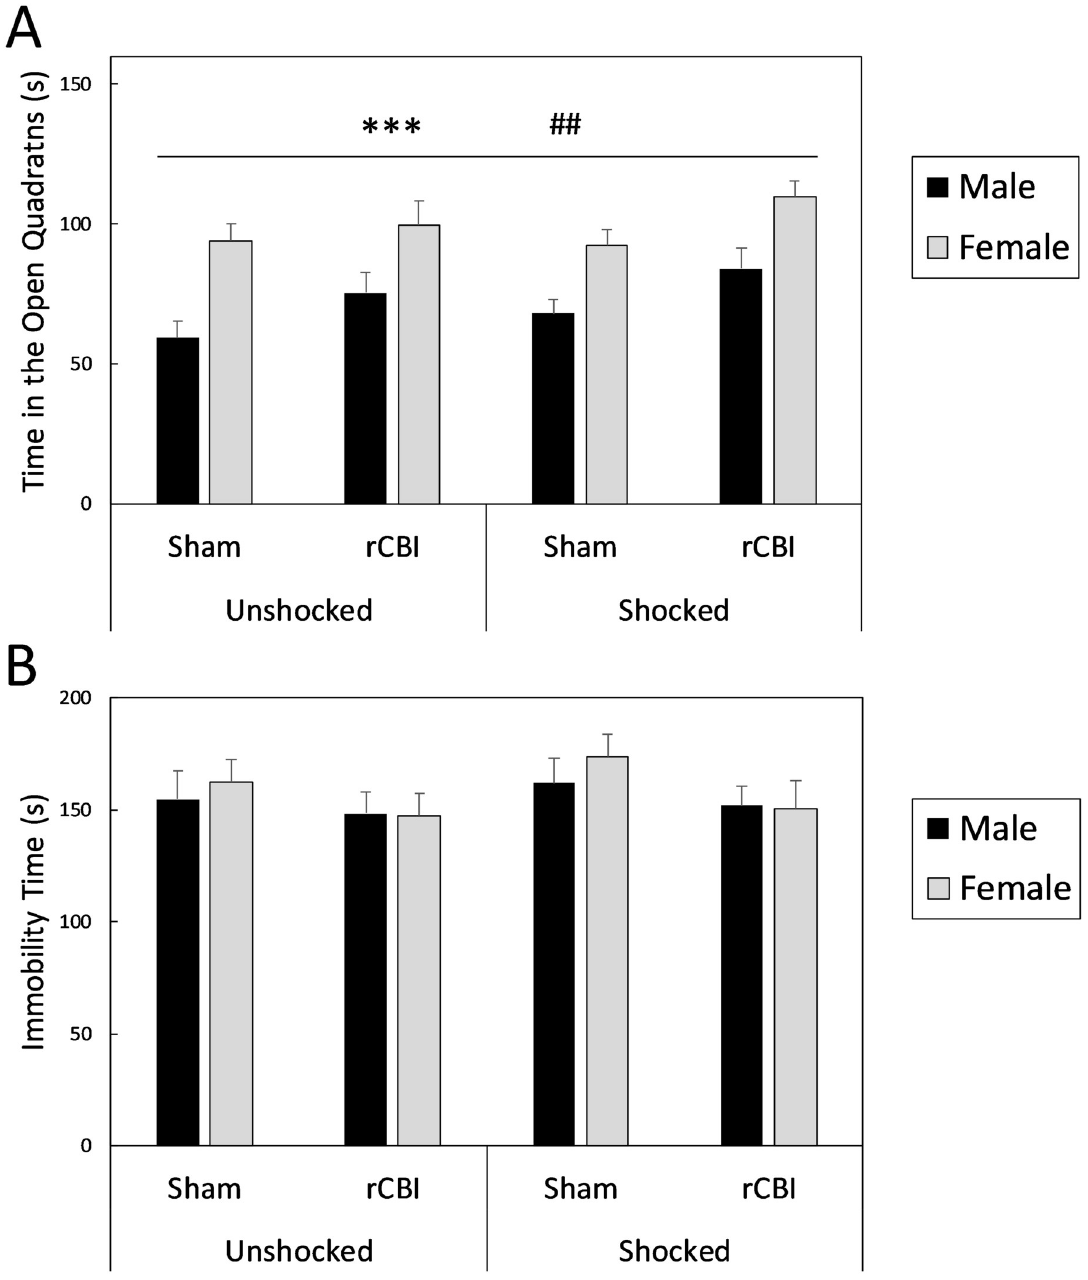
Fig 10. Anxiety- and depressive-like behaviors in the EZM (A) and TST (B), respectively. There were significant effects of both injury (##, rCBI > Sham, p < 0.01) and sex ( ��� , Female > Male, p < 0.0001) on the time spent in the open (anxiogenic) regions of the EZM, with mice that had sustained rCBI and female mice spending more time in the open quadrants of the apparatus than sham-treated and male mice, respectively ( A ). In the TST ( B ), there were no effects of injury or sex on the amount of time spent immobile. Shock status did not influence behavior in either test. EZM, elevated zero maze; TST, tail suspension test; rCBI, repetitive concussive brain injury.